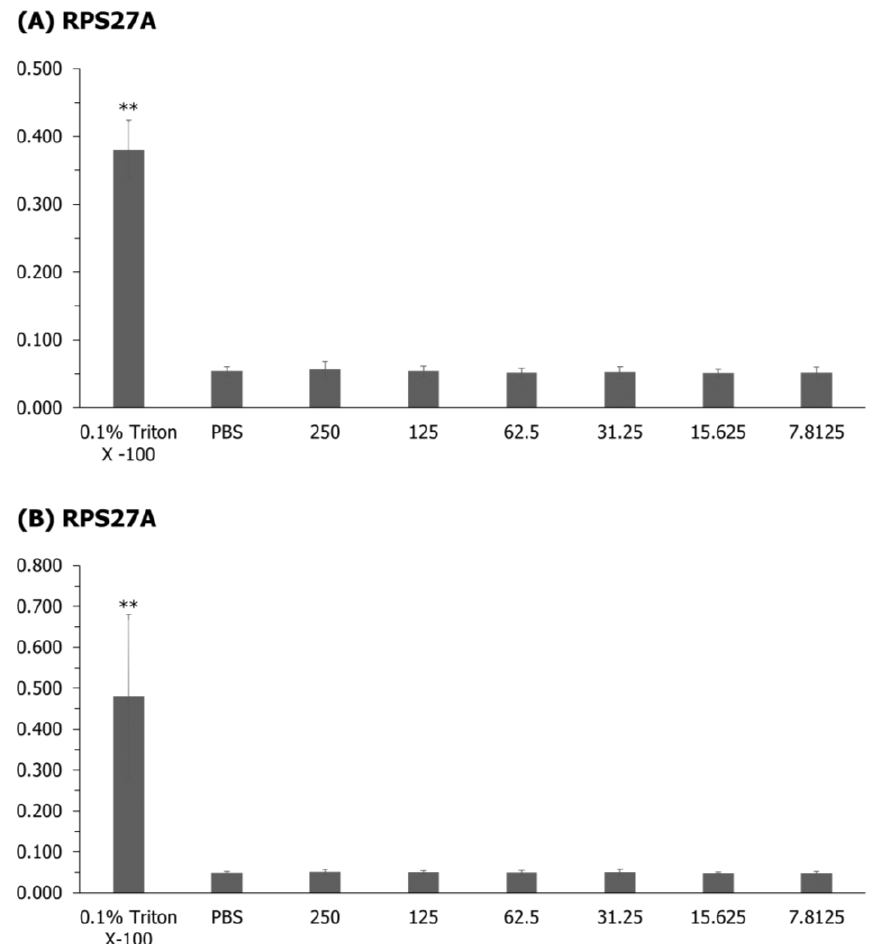
Figure 6. The hemolytic and cytotoxicity of RPS27A ( A ) and S30FAU ( B ) were analyzed using starry flounder red blood cells. The positive control was measured by adding 0.1% Triton X-100 solution. Values are expressed as the mean ± SD, and asterisks indicate a significant difference from the negative control (PBS buffer) (** p < 0.01).